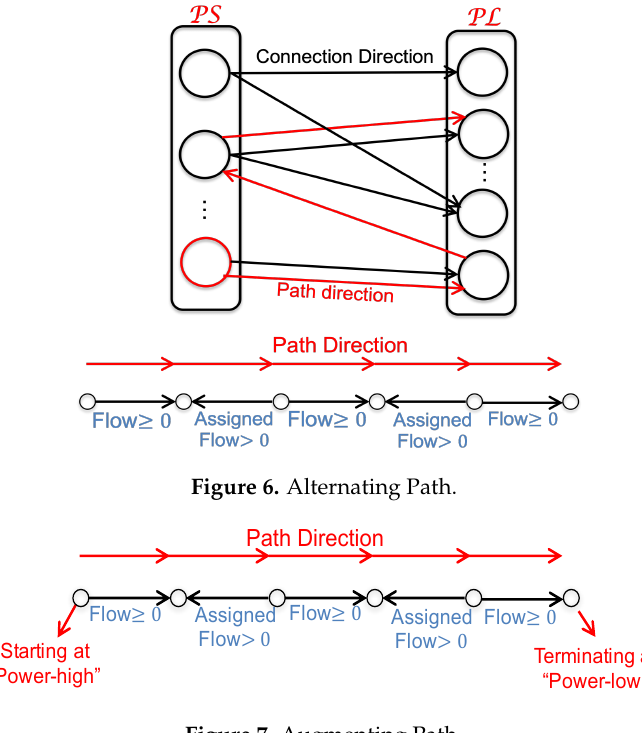
Figure 7. Augmenting Path.